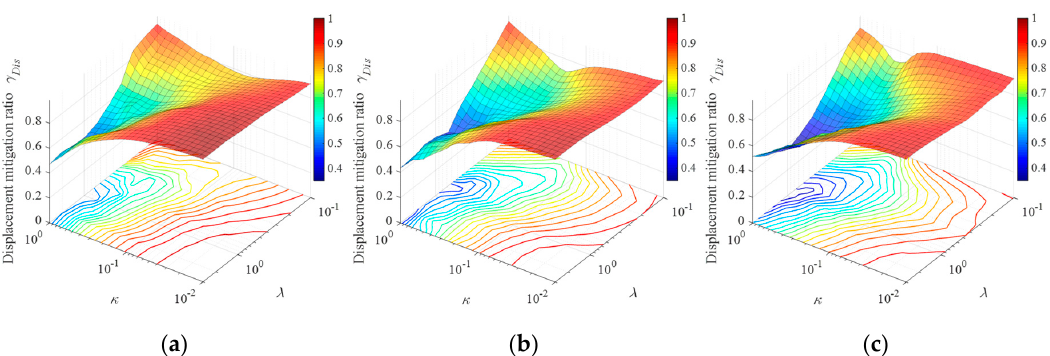
Figure 9. Variation of γ for (a) μ= 0.10 , (b) μ= 0.20 , and (c) μ= 0.30 .